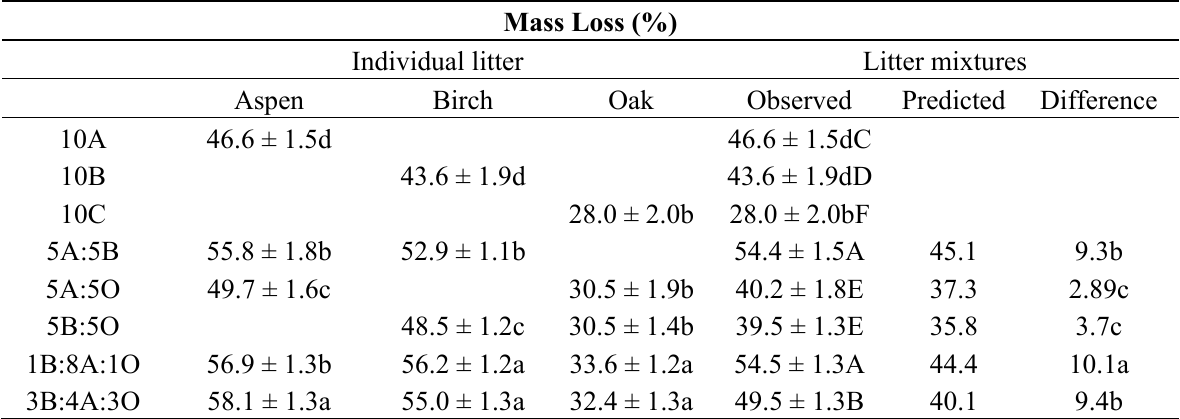
Table 2. Mass loss of individual types of litter over 360 days for three tested leaf litter species and litter mixtures (means ± SE; n = 3) .